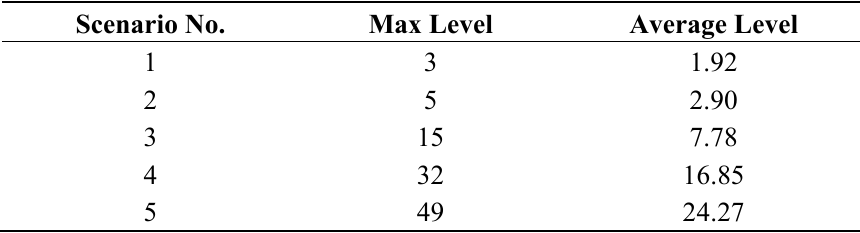
Table 3. Results of level building